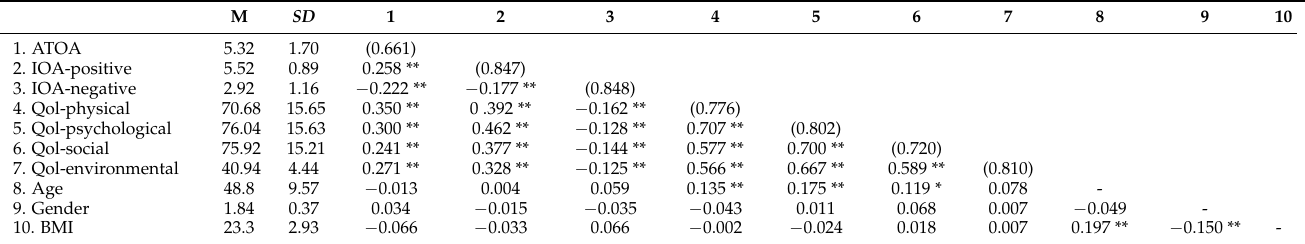
Table 1. Descriptive statistics, alpha coefficients (in parentheses), and